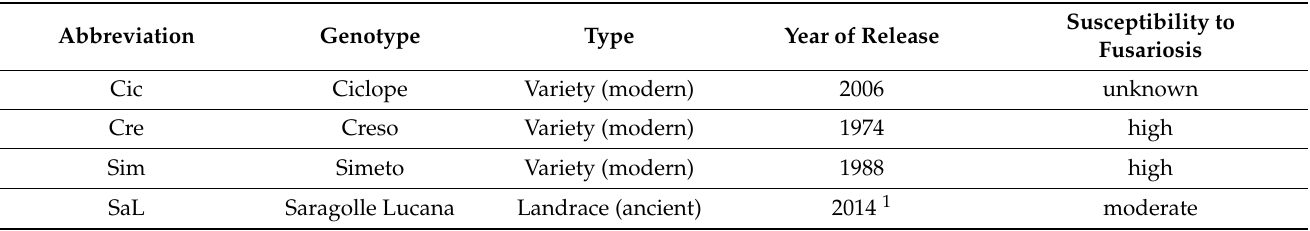
Table 1. Characteristics of the four Italian tetraploid durum wheats used in the